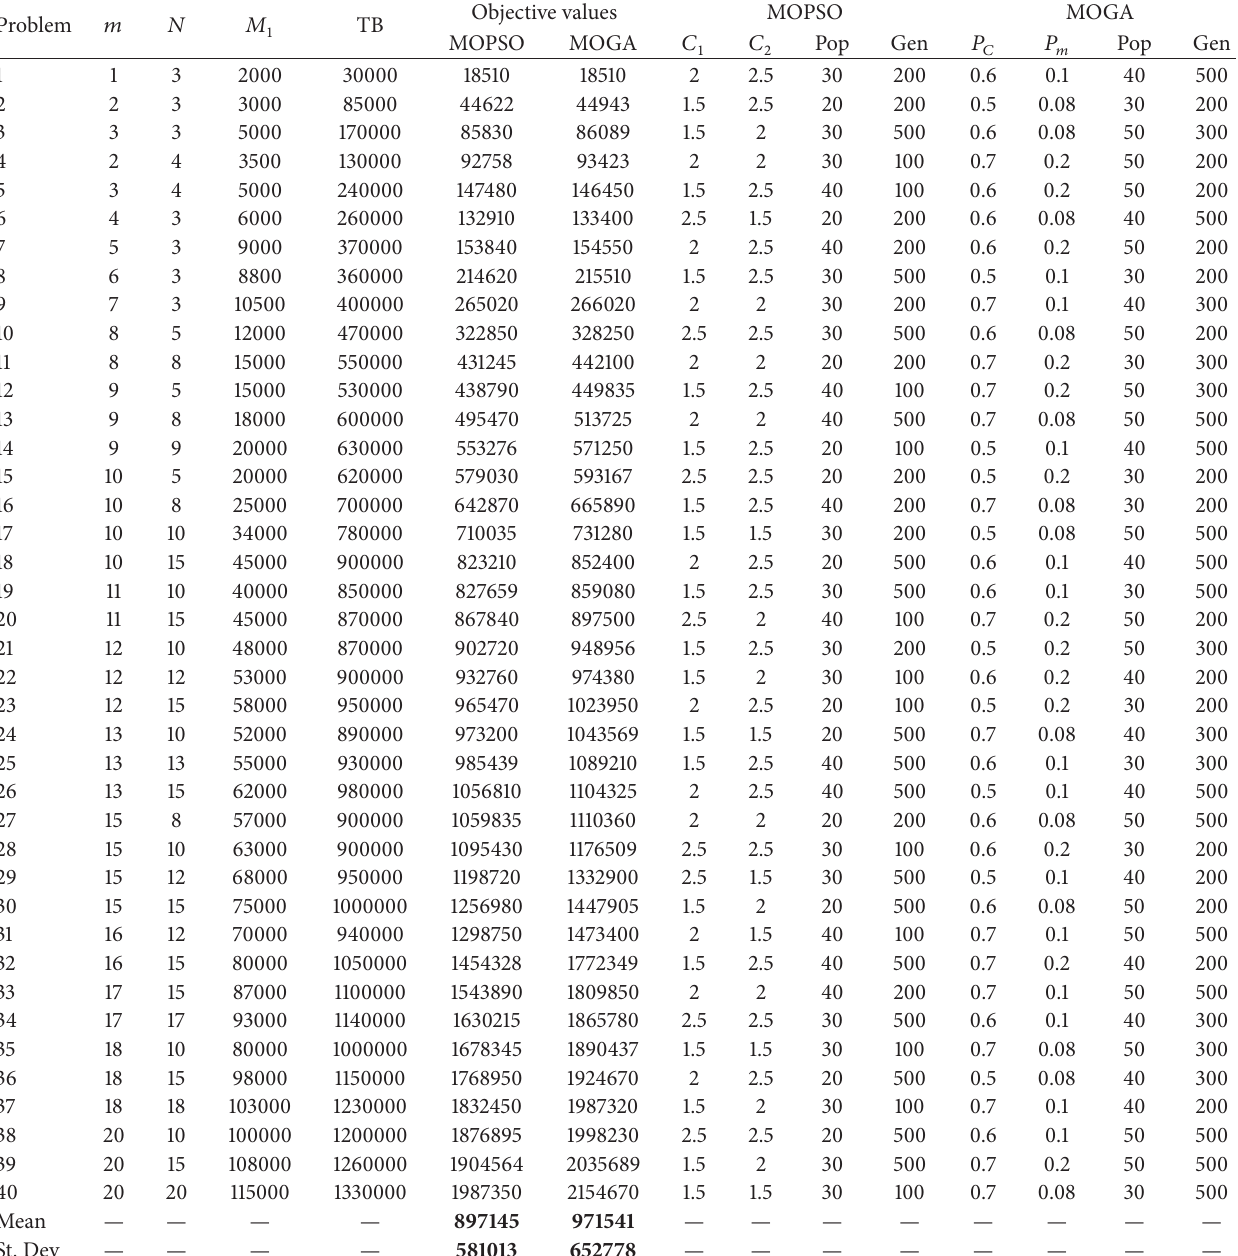
Table 2: Different problems and their optimal TMF values obtained by the two